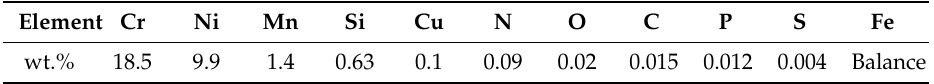
Figure 1. SEM observations of the 304L powder used in this work, showing its morphology at di ff erent Table 1. Chemical composition (in wt.%) of 304L stainless steel powder.